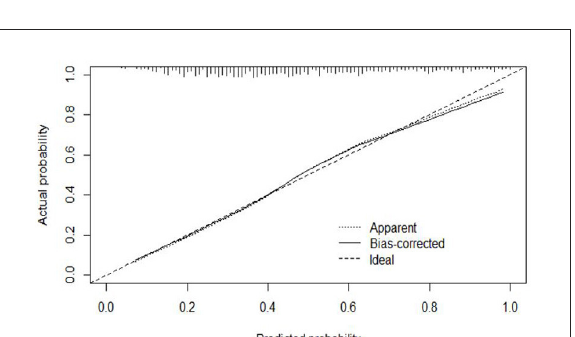
FIGURE2 Model set.